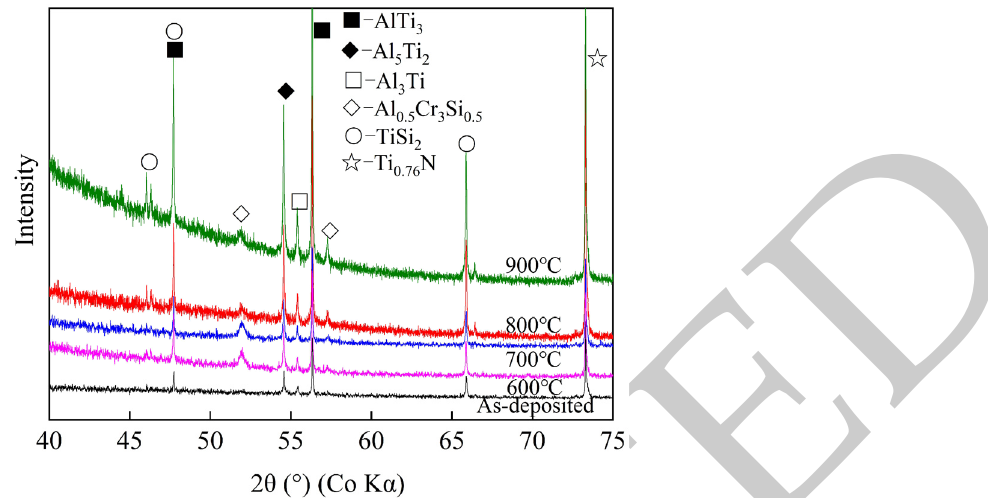
Figure 1. XRD patterns of the AlCrTiSiN coatings before and after annealing at different temperatures.